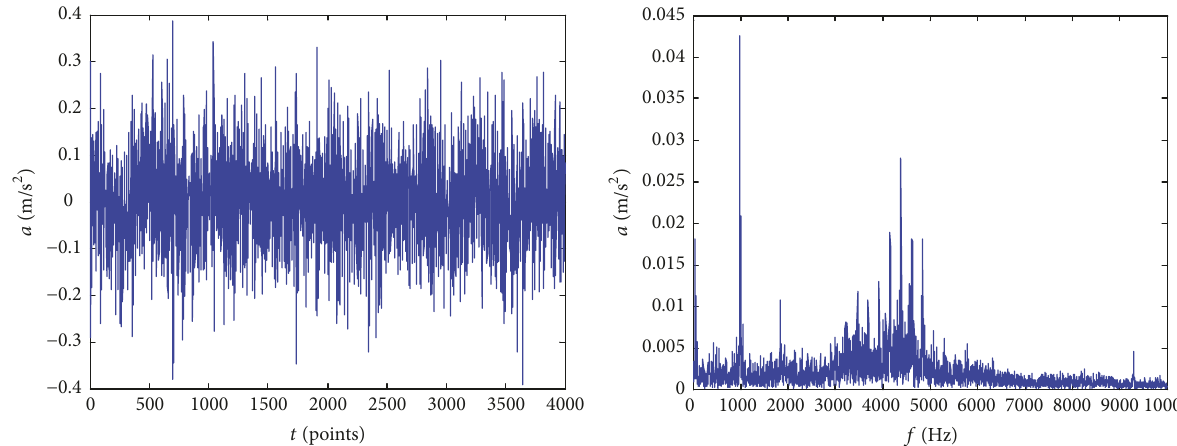
Figure 4: The vibration wave and frequency spectrum of #600.